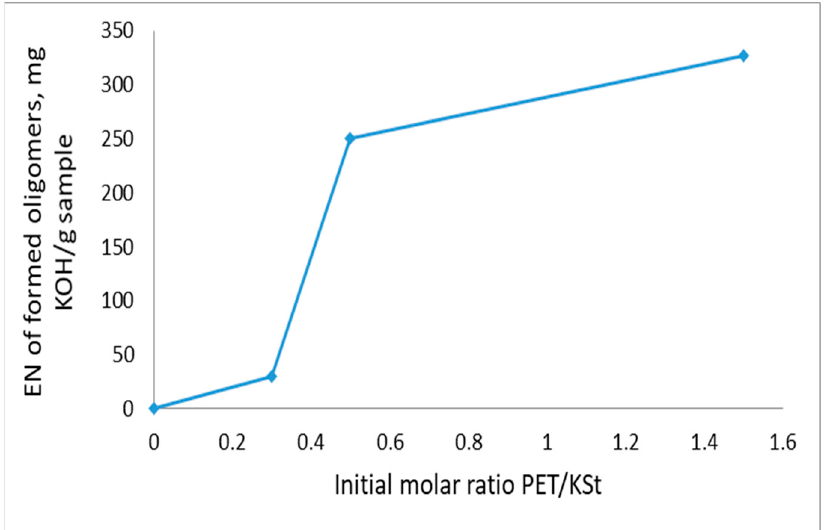
Figure 3. The change in the ether number of the formed oligomers after 300 min of the PET depoly- merization by KSt in ethylene glycol at 170°C and a different PET/KSt ratio. At the same time, PET depolymerization in chemically pure glycerol is slower than in ethylene glycol, and significant polyether conversion cannot be achieved even after 200 min of the process (Figure 4). This fact can be explained by the lower solubility of polyester chains in glycerol [18]. As a result, at all ratios of reagents, a large excess of potassium equivalents is maintained in the solution, which leads to the complete decomposition of polyester chains to monomeric units (dipotassium terephthalate). This is confirmed by a linear increase in the weight of the precipitate with an increase in the mass of dissolved PET (Figure 5). The ester number of precipitate is close to 0 mg KOH/g and practically does not change.